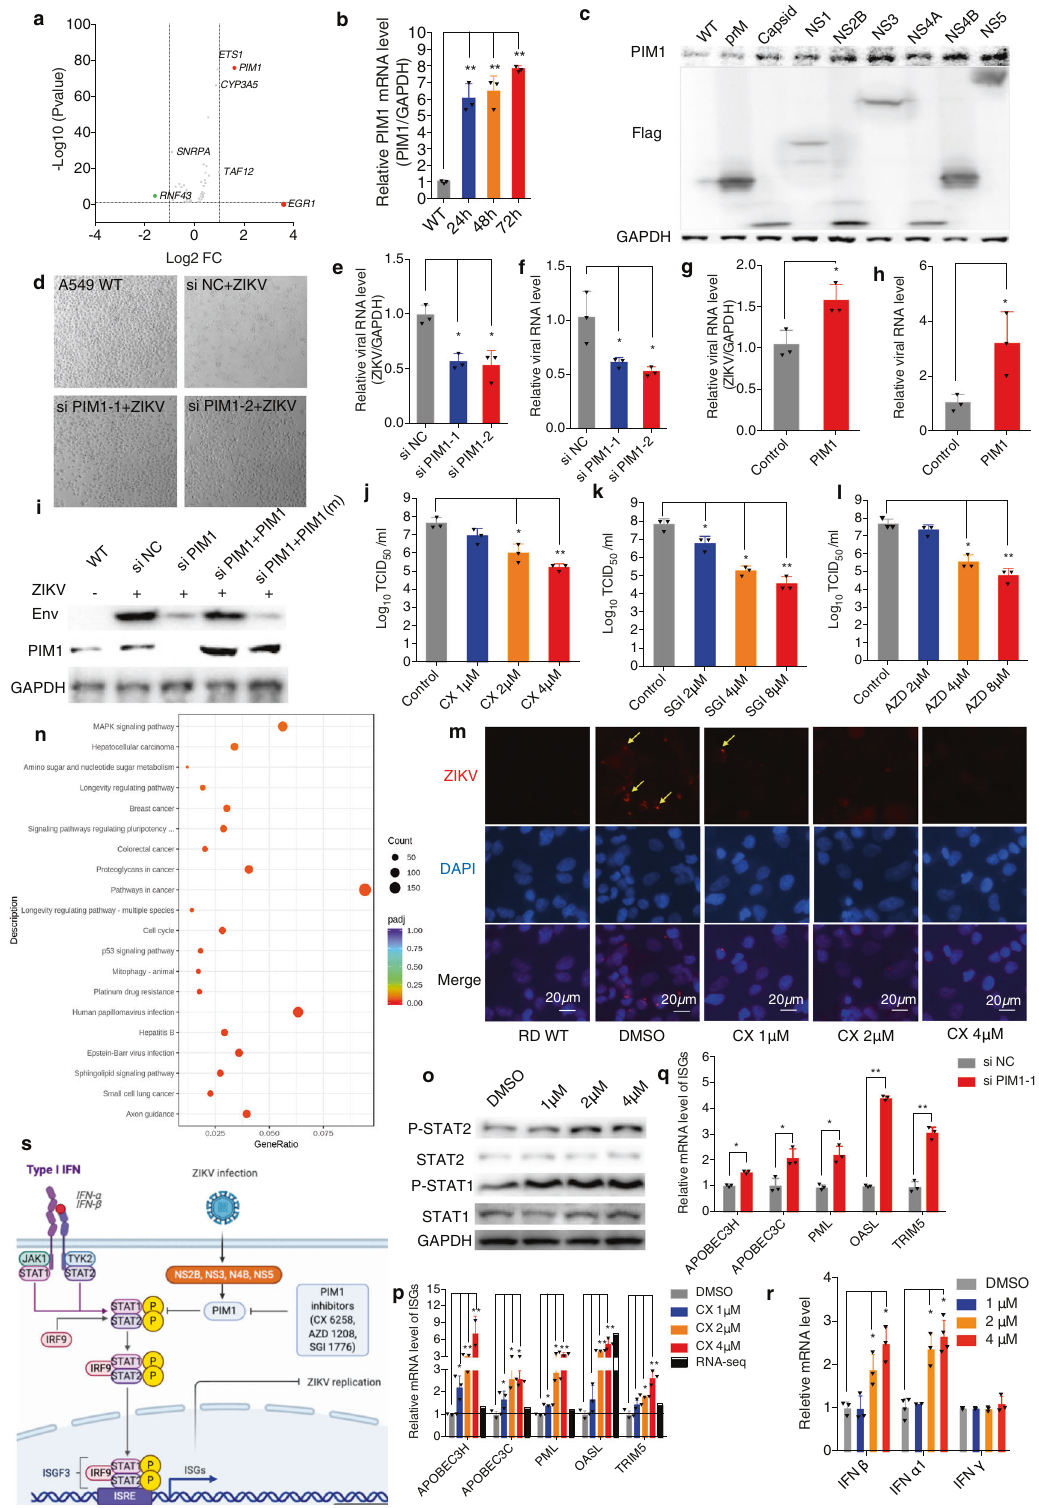
accumulated from cytoplasm to the nucleus after silencing PIM1 (Supplementary Fig. 4f). In addition, the mRNA levels of both IFN α and IFN β were signi fi cantly increased by silencing PIM1, but not affecting IFN γ expression level (Supplementary Fig. 4g). In CX- 6258-treated cells, the levels of both IFN α and IFN β were